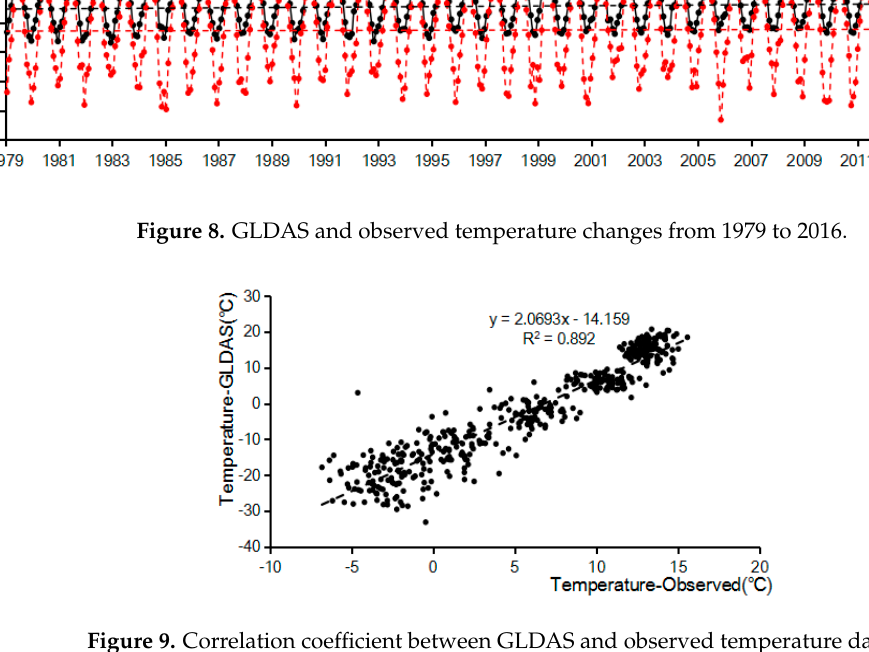
Figure 9. Correlation coefficient between GLDAS and observed temperature data.